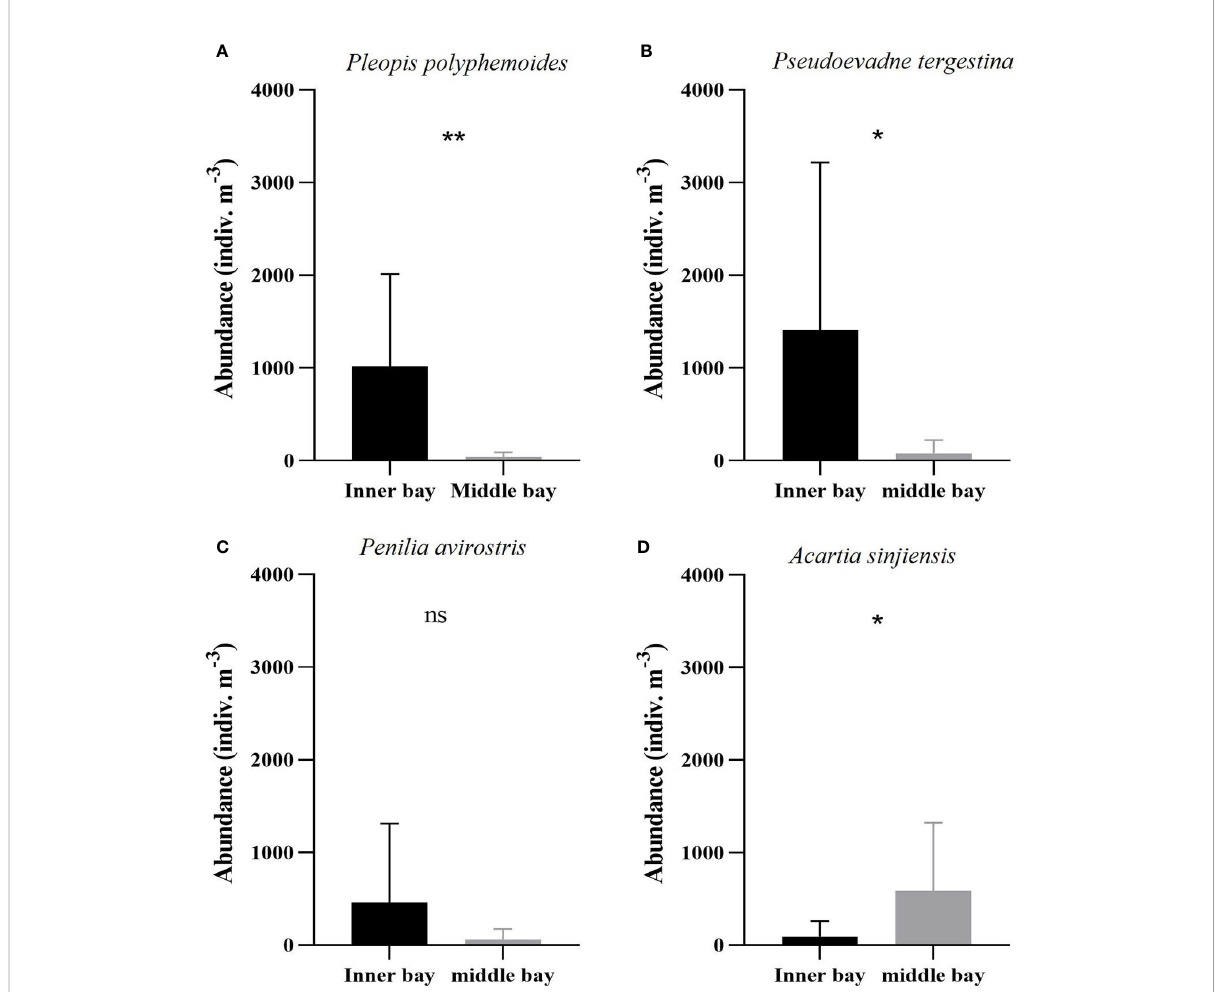
FIGURE 6 Mean dominant species abundance including (A) Pleopis polyphemoides , (B) Pseudoevadne tergestina , (C) Penilia avirostris , and (D) Acartia sinjiensis in the inner bay and the middle bay of Gamak Bay during the hypoxic period (from June to September). Spatial differences in dominant species abundance were tested with Man-Whitney U-tests. Asterisks stand for signi fi cant-difference levels between inner and middle bay: * p < 0.05; ** p < 0.01; ns, not signi fi